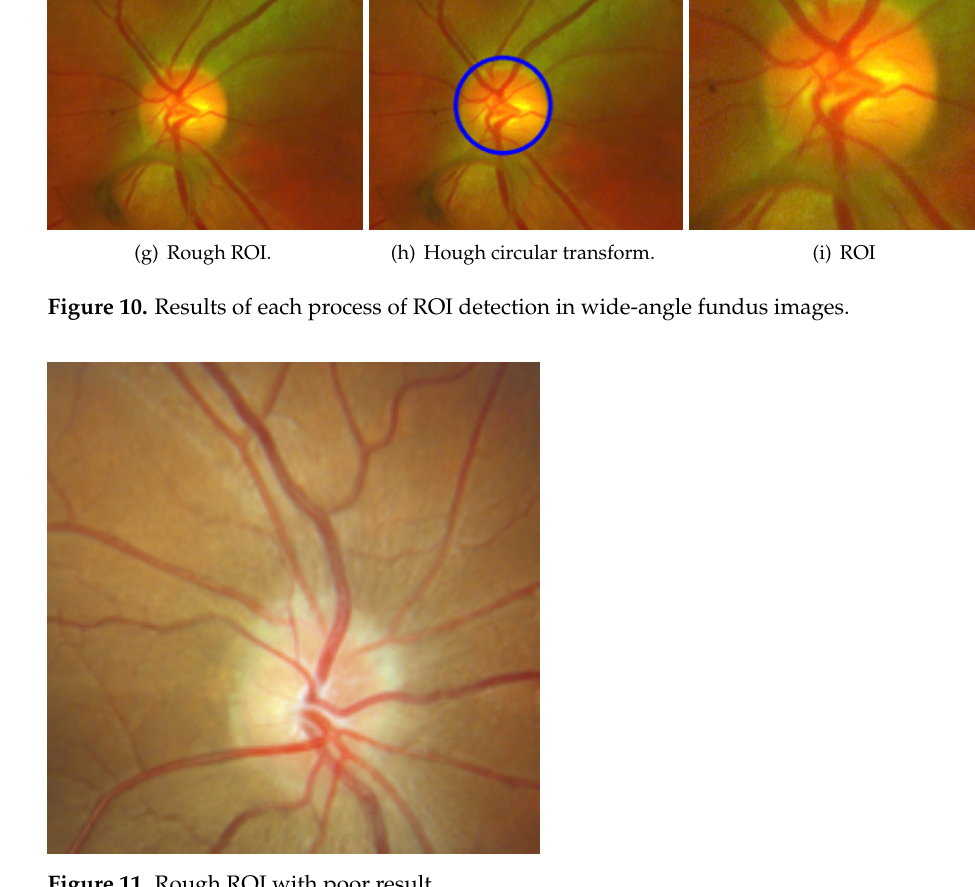
Figure 11. Rough ROI with poor